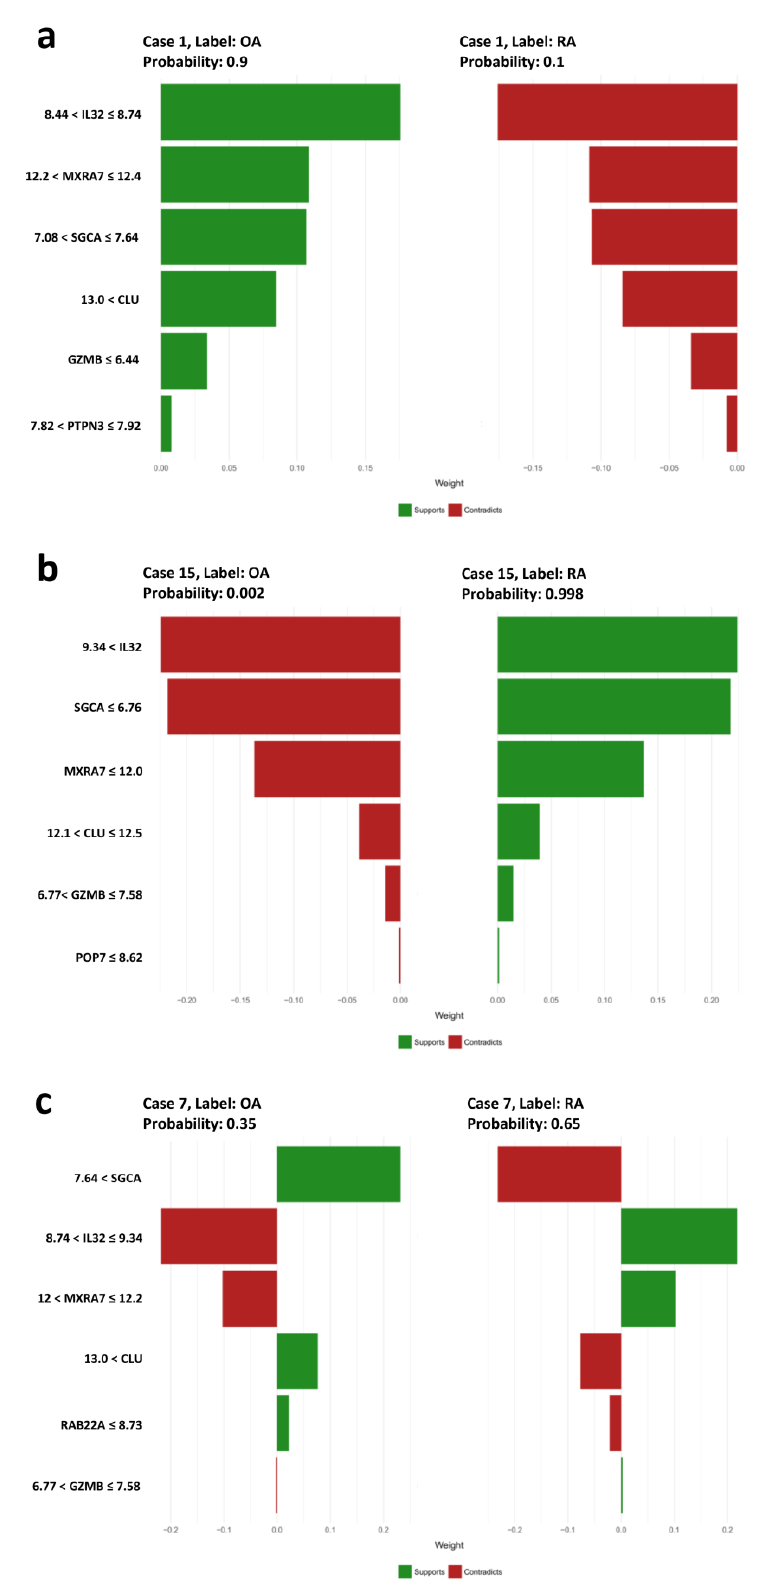
Figure 4. The use of LIME to explain the model′s predictions. ( a ) Corrected classification of an OA sample. ( b ) Corrected classification of an RA sample. ( c ) Noncorrected classification of a sample from OA to RA. RA: Rheumatoid arthritis; OA: osteoarthritis.